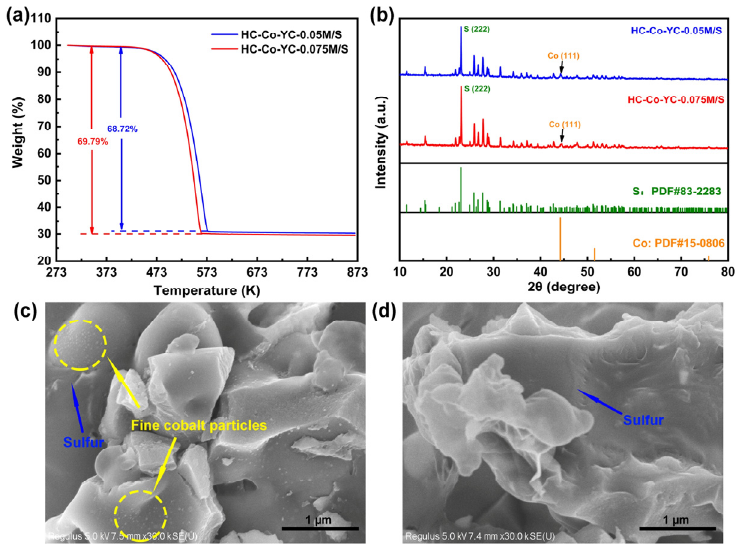
Figure 4. ( a ) TGA curves and ( b ) XRD patterns of HC–Co–YC–0.05M/S and HC–Co–YC–0.075M/S, and SEM images of ( c ) HC–Co–YC–0.075M/S and ( d ) HC–Co–YC–0.05 M/S.